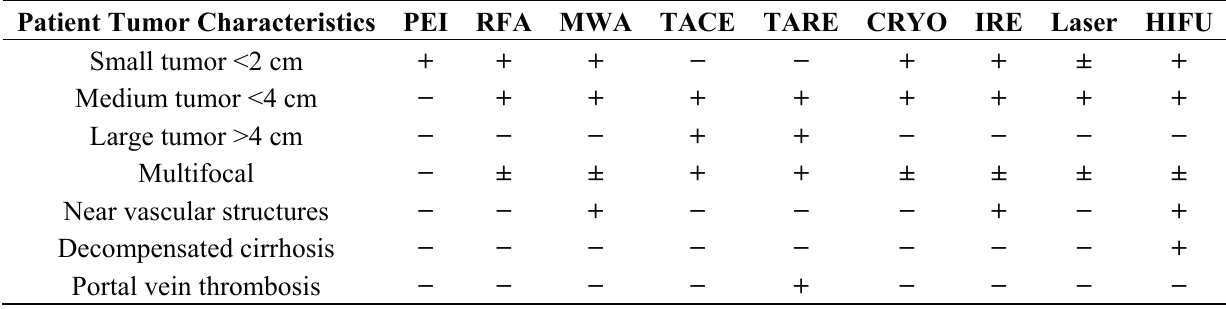
Table 3. Comparison of ablation